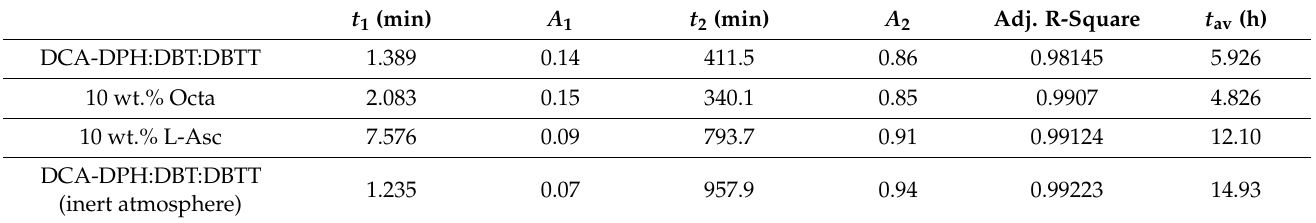
Figure 6. PL emission intensity ratios of bare DCA-DPH:DBT:DBTT (full black square) and DCA- DPH:DBT:DBTT with 10 wt.% L-Asc (full blue circle) and 10 wt.% Octa (full red square) as a function of UV light exposition time. Dotted lines are bi-exponential fits (see Table 2). Table 2. Parameters of bi-exponential fits and corresponding decay times of the photodegradation aging tests for DCA-DPH:DBT:DBTT samples with and without 10 wt.% antioxidants, prepared in air or in an inert atmosphere (t av =